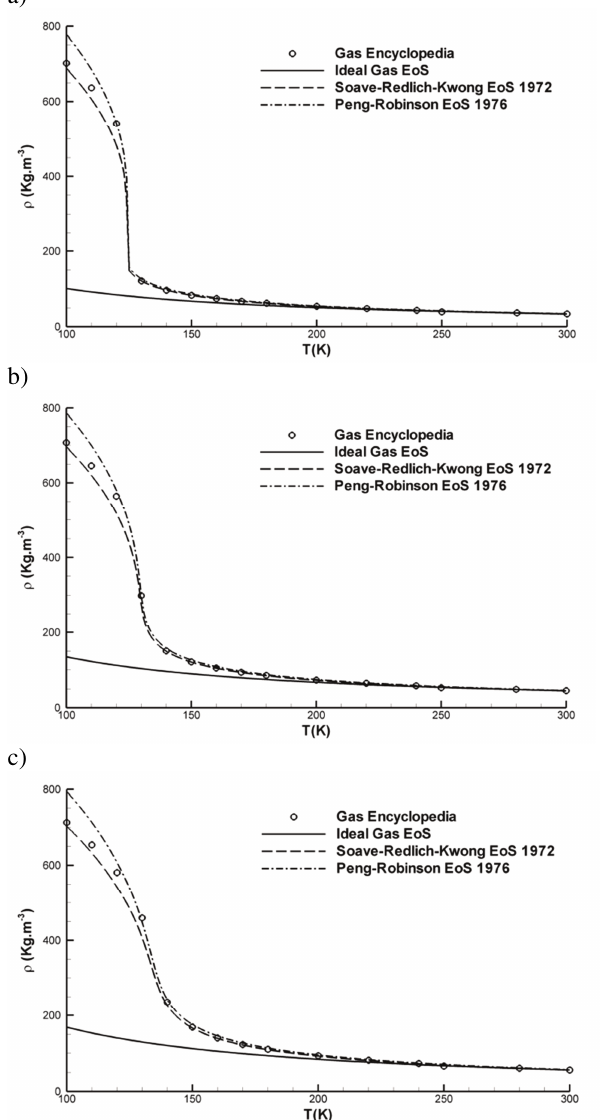
Fig. 2. Comparison of different equations of state at: a) 3 MPa; b) 4 MPa; c) 5